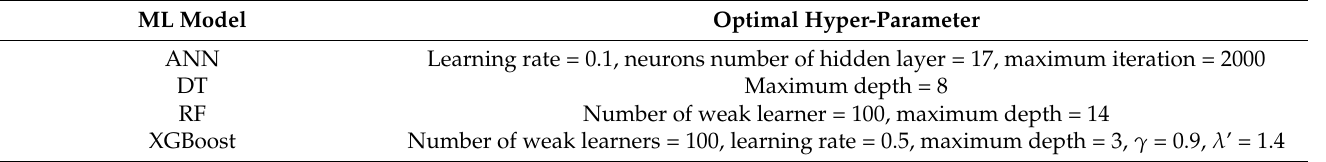
Table 2. Optimal hyperparameters of ML